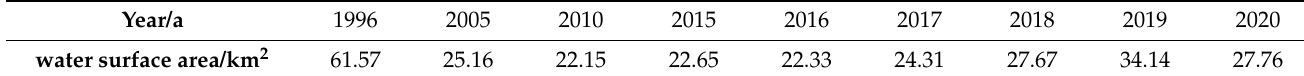
Table 1. The water surface area of Eichmann Lake from 1996 to 2020.